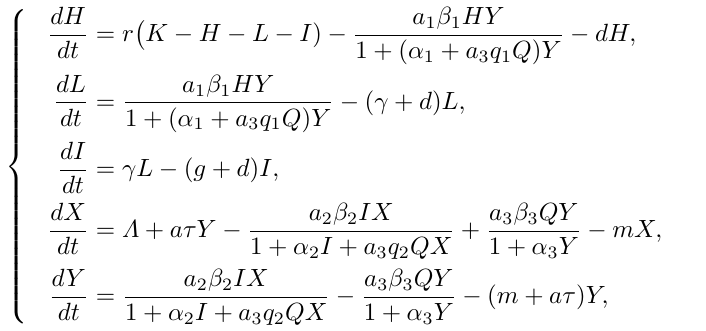
Figure 1. Schematic diagram of the formulated PVY disease model in a mixed-cropping system comprised of host and non-host crop plants.